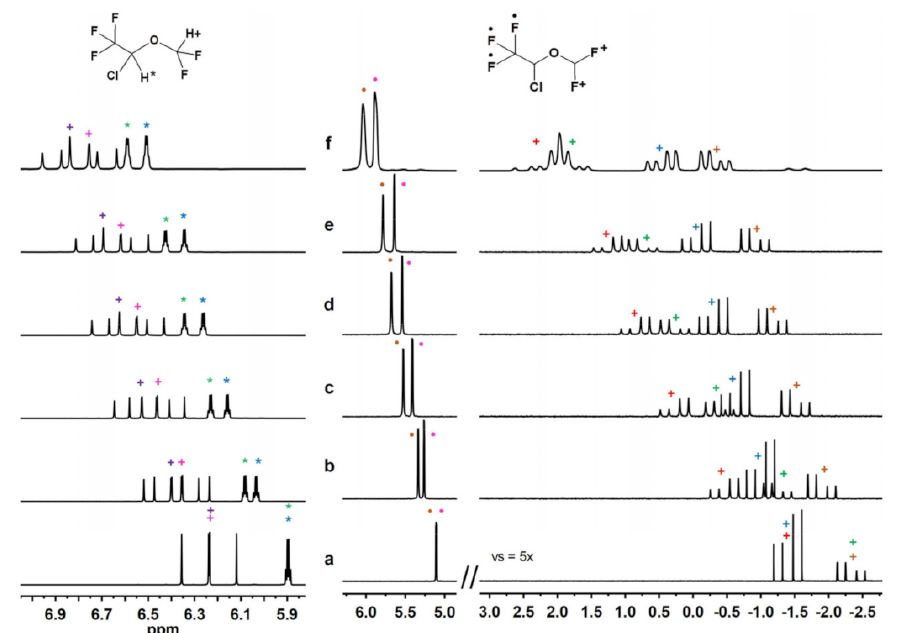
Figure 2. 1 H (600 MHz, 25 ◦ C, C 6 D 12 ) ( left ) and 19 F (564 MHz, 25 ◦ C, C 6 D 12 ) ( right ) NMR spectra of racemic ISO (30 mM) alone ( a ) and in the presence of AcSi γ CD to give an ISO/CD molar ratio of 8:1 ( b ), 4:1 ( c ), 3:1 ( d ), 2:1 ( e ) and 1:1 ( f ). The different colors help in visualizing the splitting of